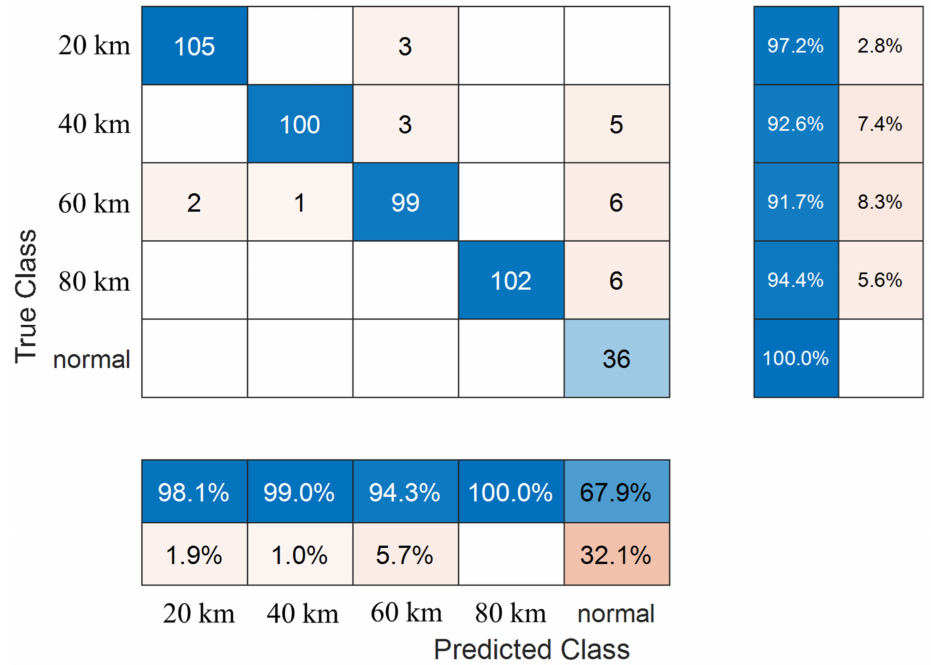
Figure 13. Confusion matrix of fault location classification model with 1/2 cycle data input.